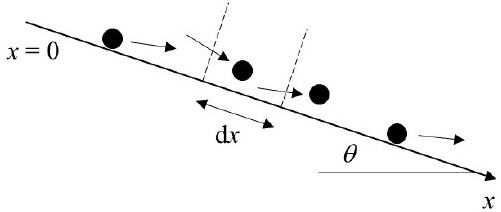
Figure 1. Definition diagram of surface inclined at angle θ and con- trol volume with edge length d x through which particles move. Fig- ure reproduced from companion paper (Furbish et al.,